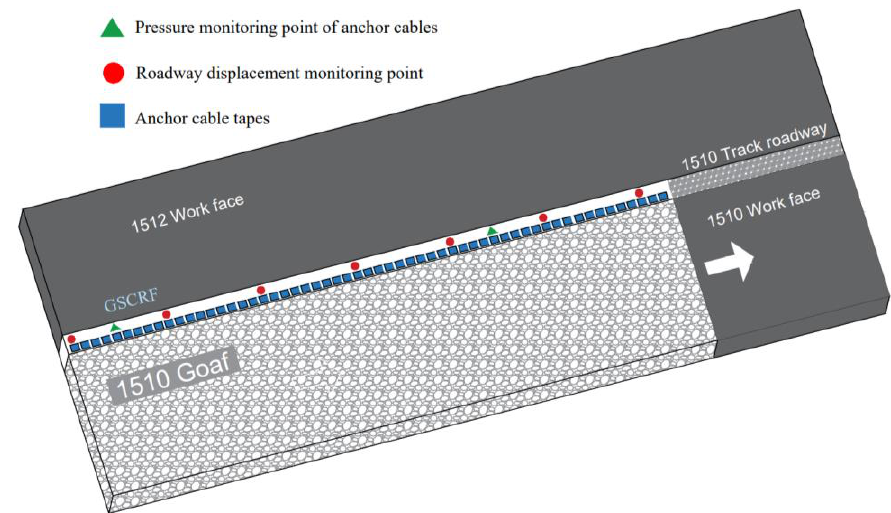
Figure 16. Schematic diagram of monitoring